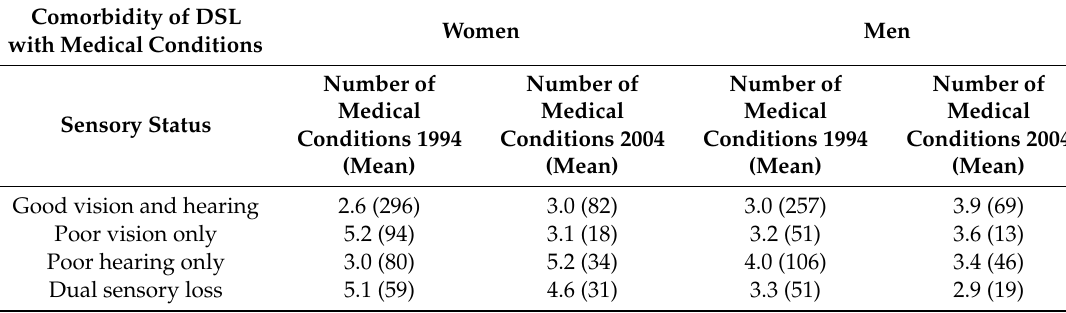
Table 6. Comorbidity of DSL with other medical conditions in 1994 and